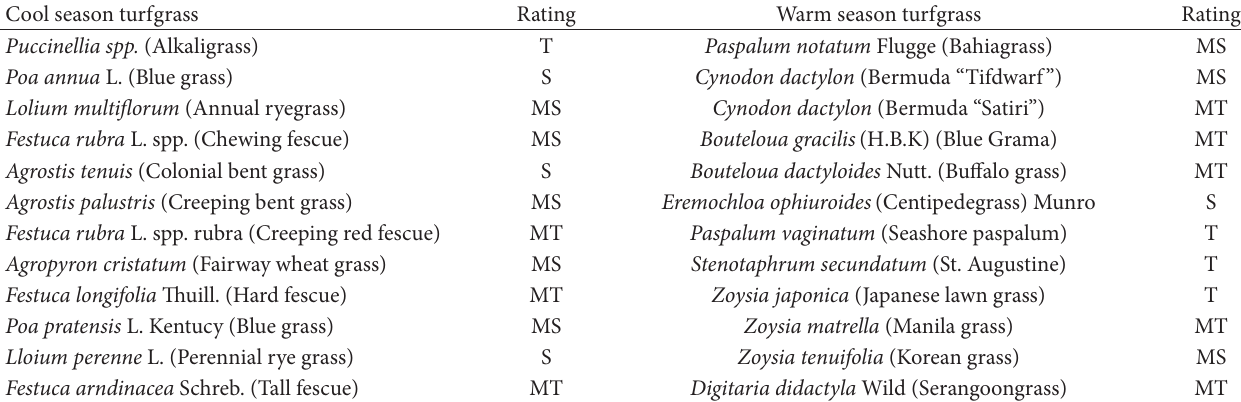
Table 1: Estimated salt tolerance of common cool and warm season turfgrass [8, 56,